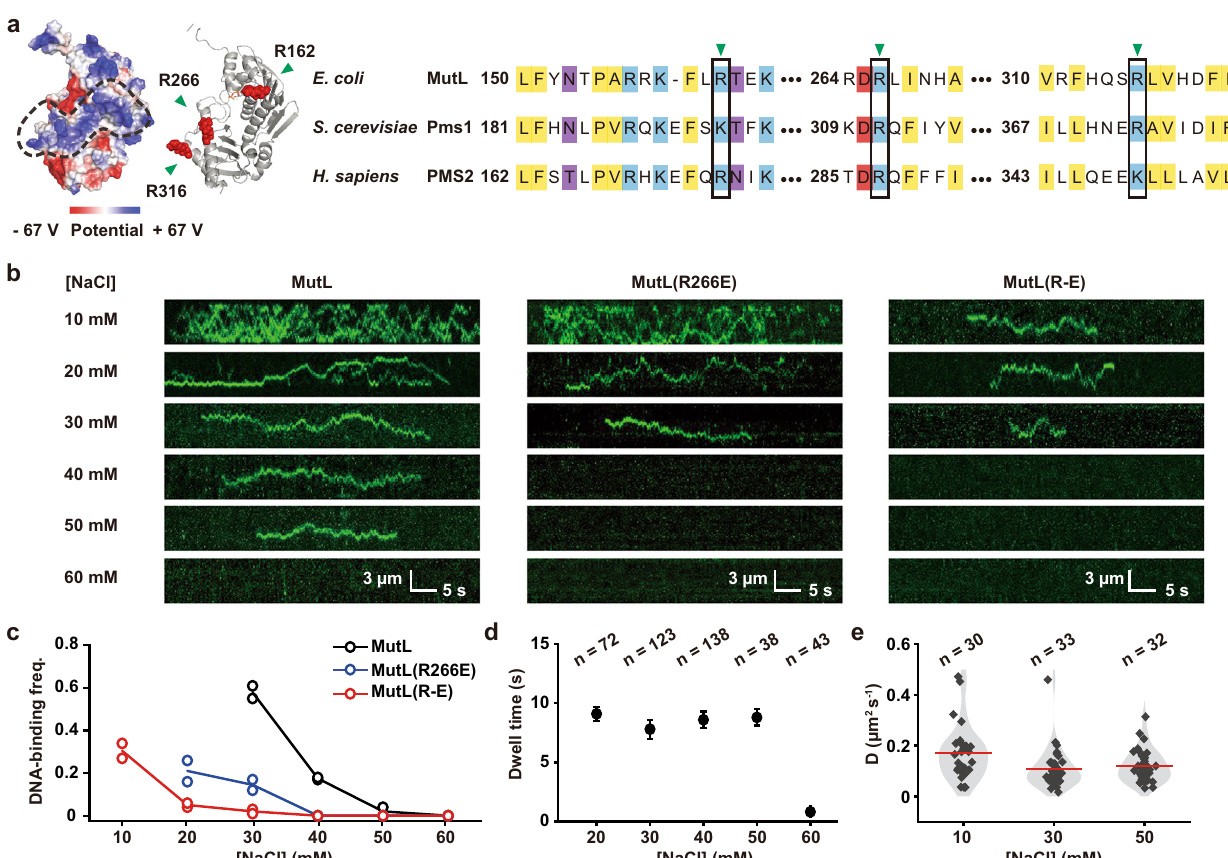
Fig. 1 | The MutL NTD is responsible for low ionic strength DNA binding activity. a Left: color-coded electrostatic surface potential diagram of MutL NTD identifying the positively charged cleft (PCC, black dashed circle; PDB ID: 1B62) with the location of previously examined DNA interaction residues indicated by greenarrowheads.Right:sequencealignmentofNTDPCCbetween E.coli MutLand the MutL homologs Pms1 and PMS2 of S. cerevisae and human, respectively. Pre- viously examined DNA interaction residues indicated by green arrowheads and black rectangles. Conserved hydrophobic residues are shaded in yellow, basic in blue,acidicinred,andothersinpurple. b Representativekymographsshowingthe binding and diffusions of MutL, MutL(R266E) or MutL(R-E) (2nM) on mismatched DNA under various ionic conditions. c The frequency of MutL, MutL(R266E) or